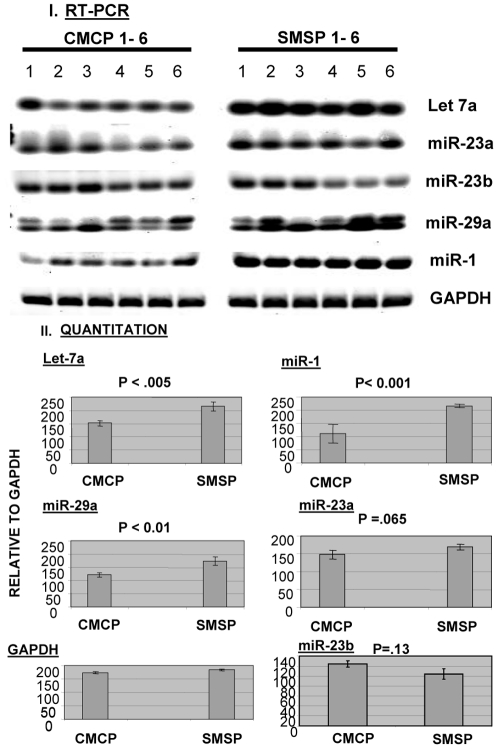
Semi-quantitative RT-PCR analysis of microRNAs in male SKM samples.
I. The total RNA (1 µg) has been used to make cDNA using Ambion mirVana isolation kit. Equal amount of cDNA has been used in separate microRNA-specific PCR reactions. CMCP (1-6) and SMSP (1-6) correspond to six samples of control and starved SKM. II. Image J analyses of the intensities of all bands were plotted as graphs for each microRNAs. T-test was done as a measure of statistical analysis. GAPDH was used as an internal control.